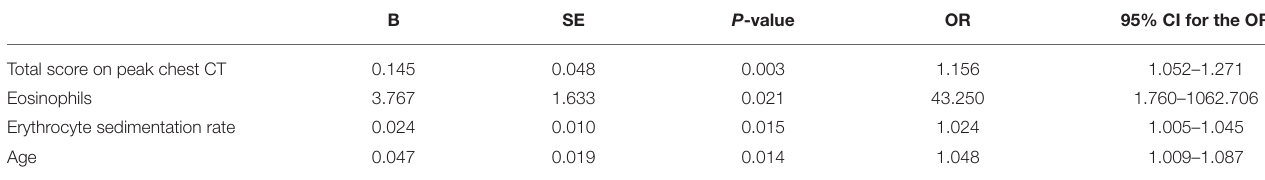
TABLE 5 | Significant risk factors for fibrotic change depicted by CT in patients with COVID-19. B SE P -value OR